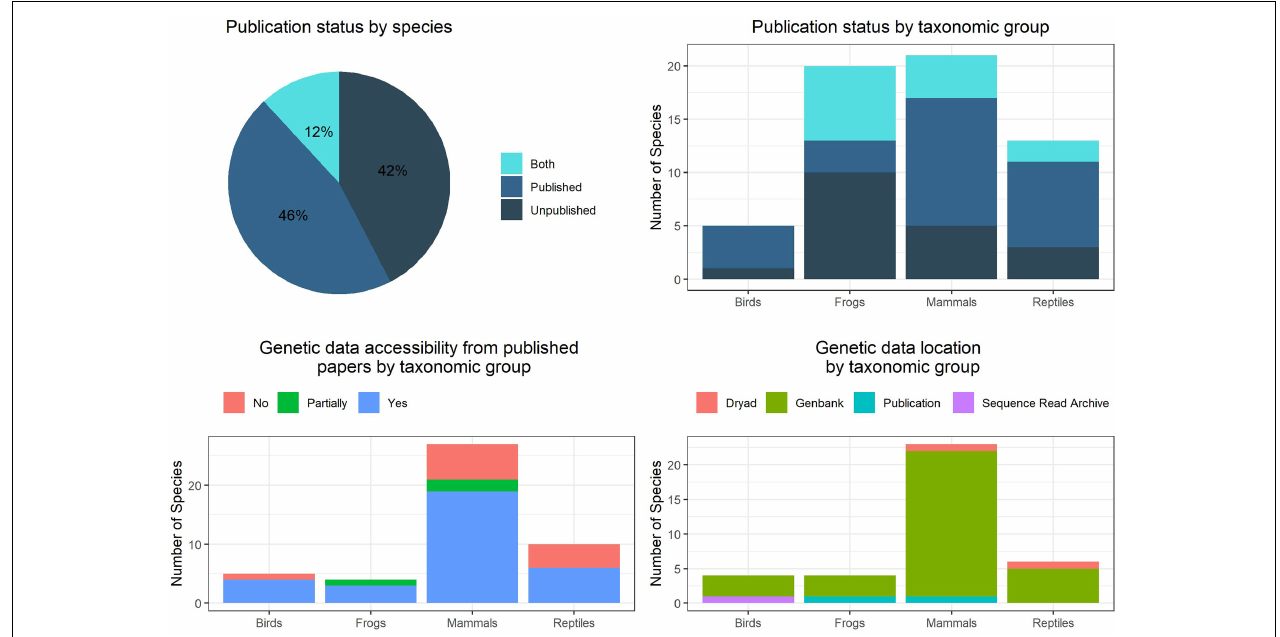
FIGURE 2 | Proportion of individual species assessments relying on published or unpublished genetic data, or a combination of both (top left) . Publication status of studies by taxonomic group (top right) . For published studies, a summary of whether the genetic data was publicly available (bottom left) , and if so, from where the data was available (bottom right)